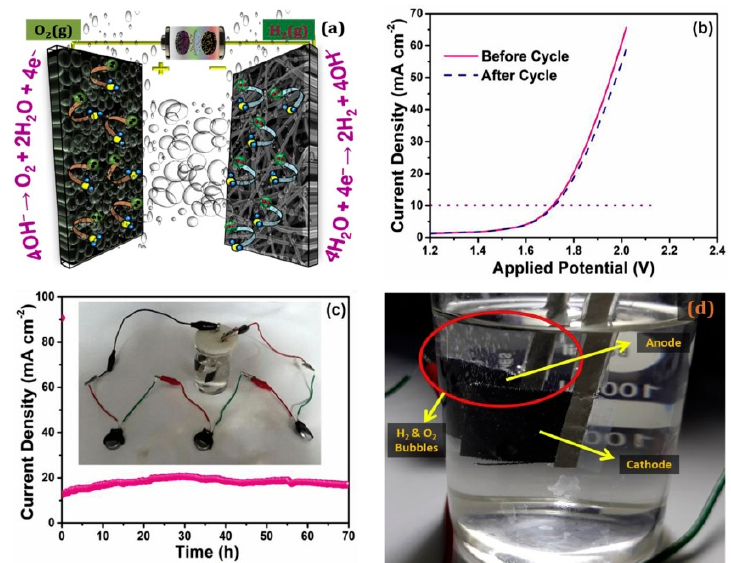
Figure 11. ( a ) Schematic of the lab-scale, hybrid, water electrolyzer with two asymmetric electrodes, ( b ) LSV of the device before and after a 70 h durability study, showing practically no change in its catalytic activity, ( c ) Chronoamperometry of the device for 70 h (inset) shows the supercapacitor assembly with water electrolyzer and ( d ) Photographic image of the generated O 2 and H 2 bubbles. Reproduced with permission from Ref. [117]. Copyright Elsevier 2019.